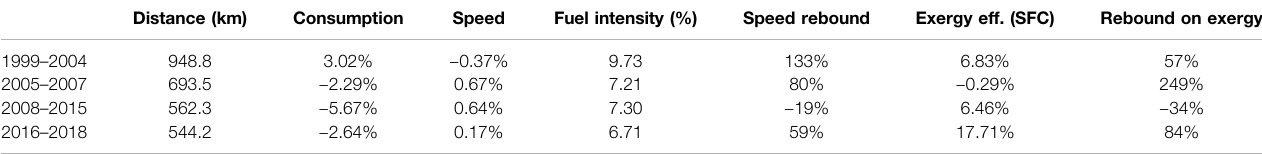
TABLE 3 | Speed rebound on energy (fuel intensity) and exergy ef fi ciency. Distance